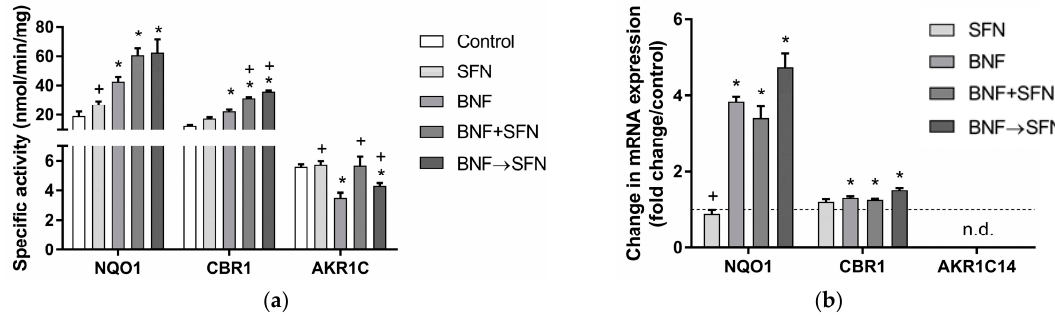
Figure 2. Effect of sulforaphane (10 μ M) on the activity ( a ) and mRNA expression ( b ) of carbonyl-reducing enzymes in rat hepatocytes treated or non-treated with β -naphthoflavone (10 μ M). Primary rat hepatocytes were incubated at 37 °C for 24 h. All enzyme activities were assessed in the cytosolic fraction. Specific enzyme activities of NADPH-quinone oxidoreductase (NQO1), carbonyl reductase 1 (CBR1) and aldo-keto reductase 1C (AKR1C) were determined as nmol of formed product (NQO1, AKR1C) or consumed cofactor (CBR1) per min per mg of protein. The data are expressed as the mean ± SD ( n = 3). The mRNA and enzyme activity significantly altered ( p ≤ 0.01) compared to control (*) or β -naphthoflavone (+). BNF β -naphthoflavone; SFN sulforaphane; BNF + SFN co-administration of BNF + SFN; BNF → SFN 6-h BNF pre-treatment followed by SFN addition; n.d. not determined.